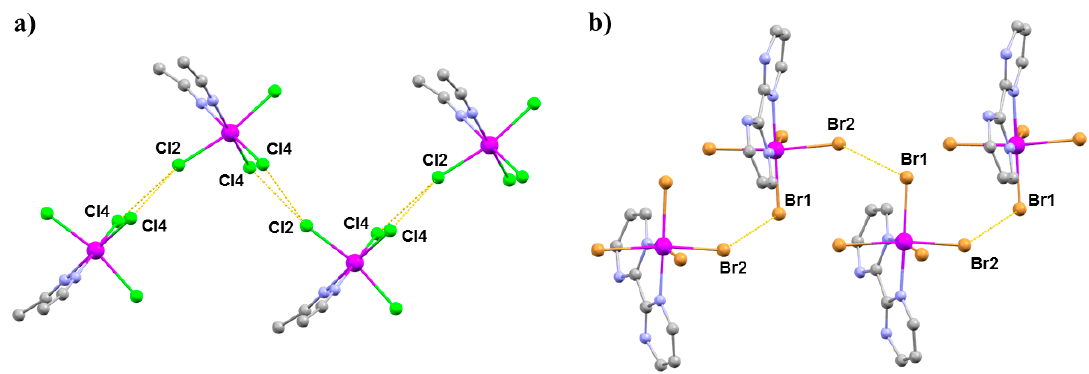
Figure 20. The extended structures of ( a ) 14 and ( b ) 15 . Colour code: Re = purple, N = blue, C = grey, Cl = green, Br = light brown. H atoms and solvent molecules are omitted for clarity. The dashed lines show the halide···halide interactions.